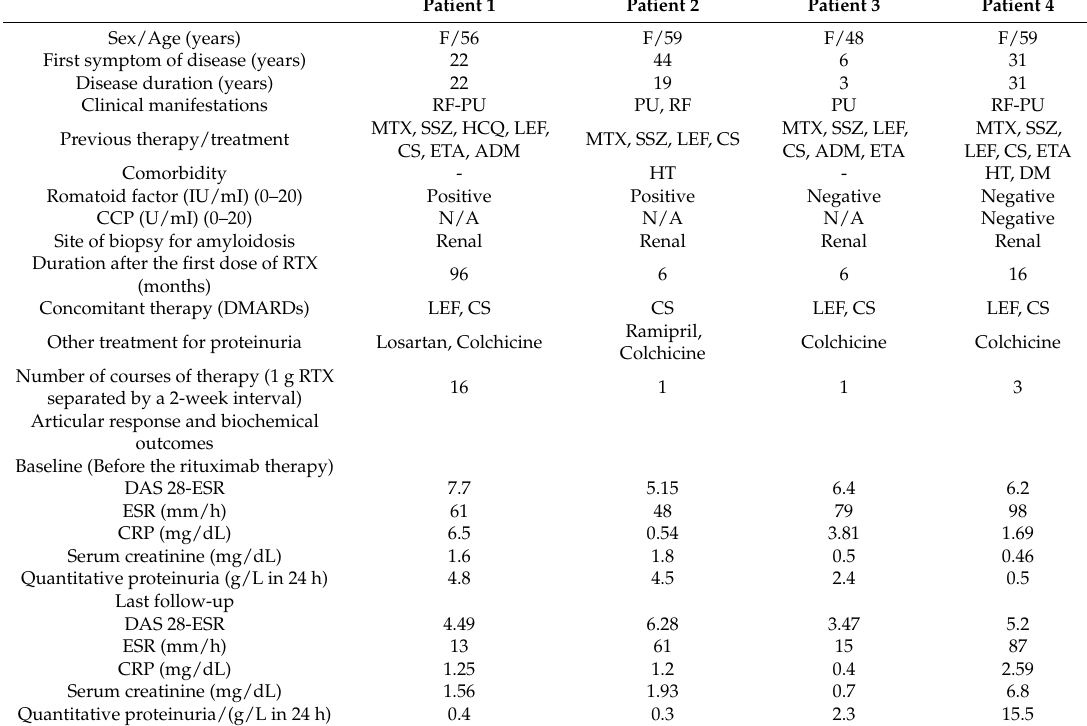
Table 1. Characteristics of patients and efficacy of rituximab therapy by rheumatoid arthritis (RA) and secondary amyloid A (AA)